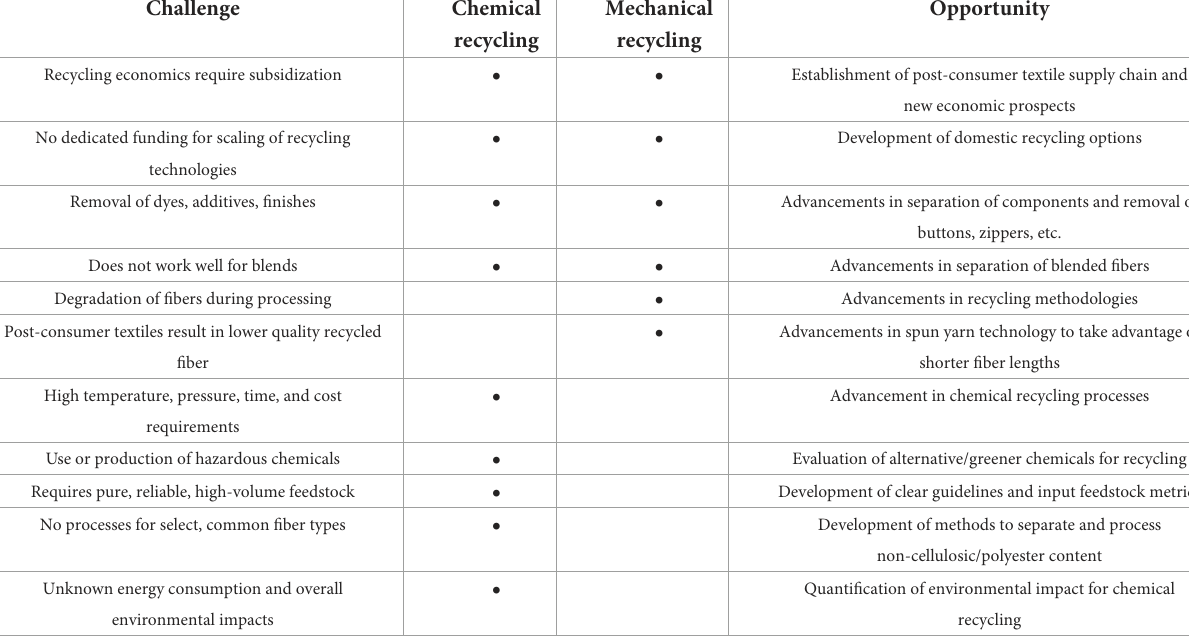
TABLE 3 Challenges and opportunities for textiles recycling (Schumacher and Forster,